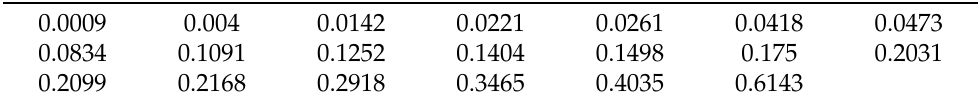
Table 10. Failures of 20 components